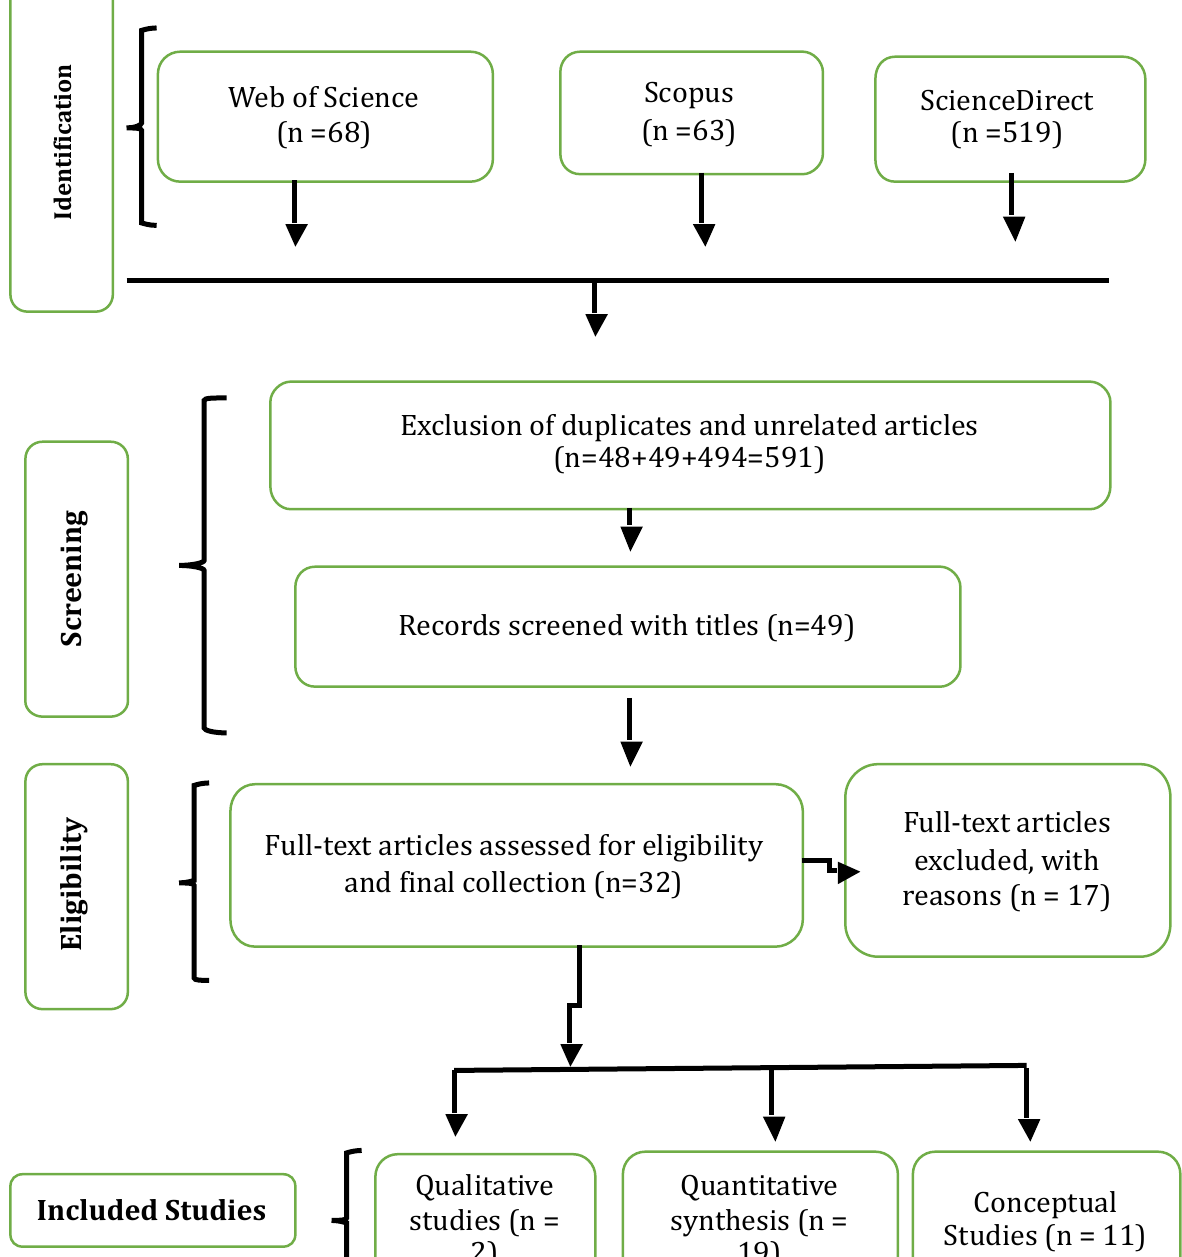
Figure 1. PRISMA model for selecting articles for this